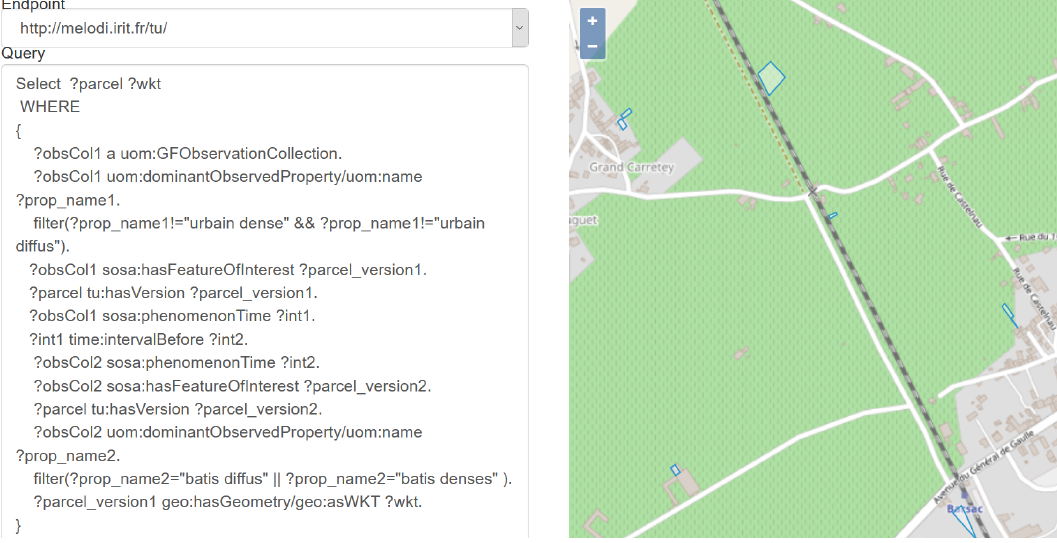
Figure 8. Location of transformed parcels (surrounded areas), from agricultural land to urban on the north west of the Barsac village between 2017 and